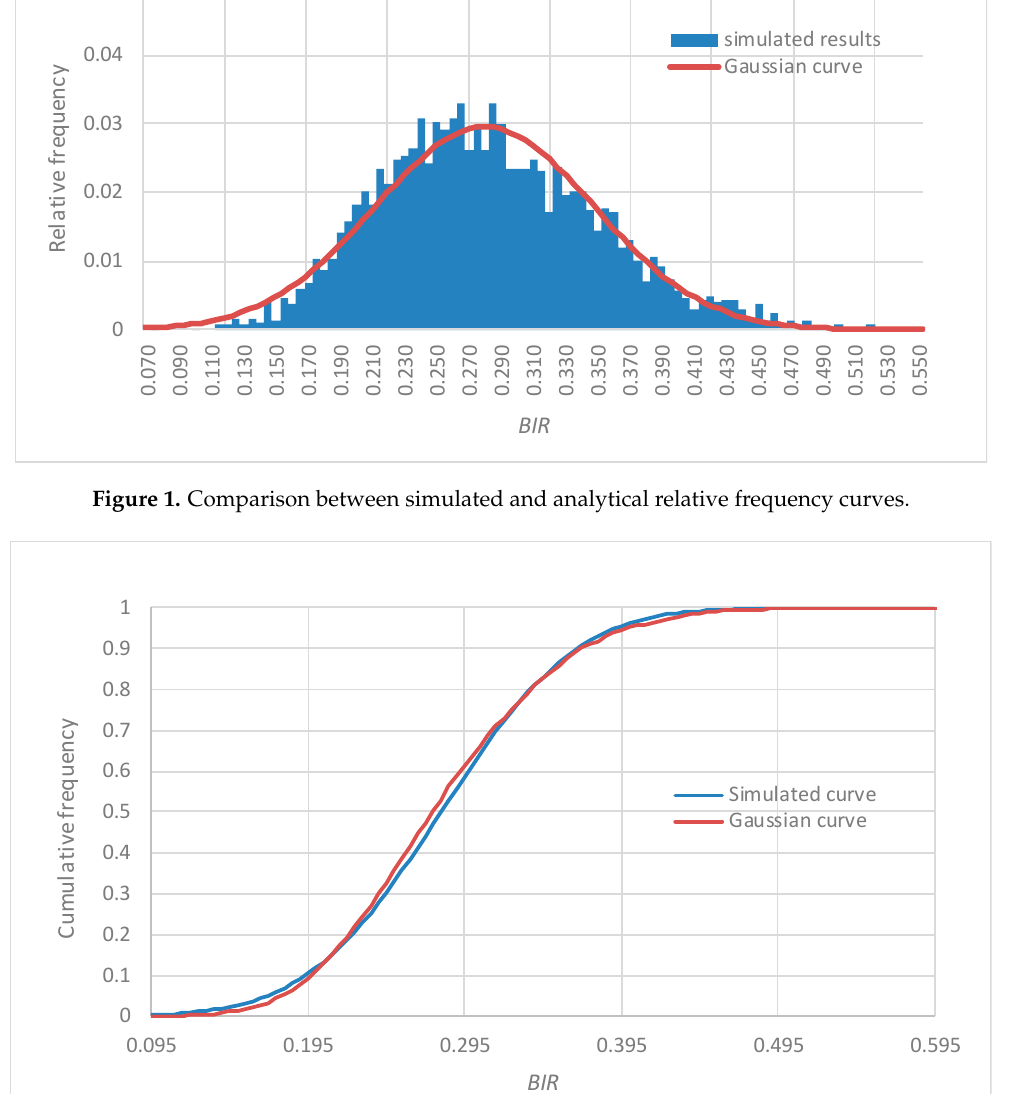
Figure 2. Comparison between simulated and analytical cumulative frequency curves.